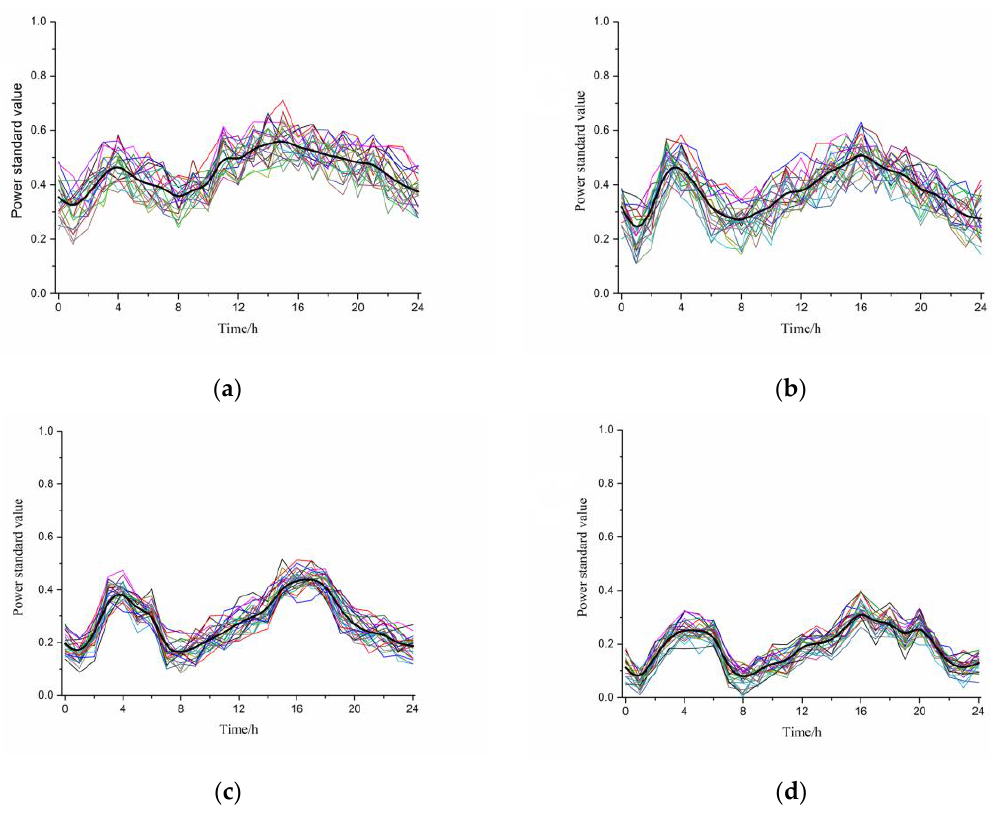
Figure 4. Wind power generation in typical scenarios ( a ) Wind power generation in scenario 1; ( b ) Wind power generation in scenario 2; ( c ) Wind power generation in scenario 3; ( d ) Wind power generation in scenario 4.